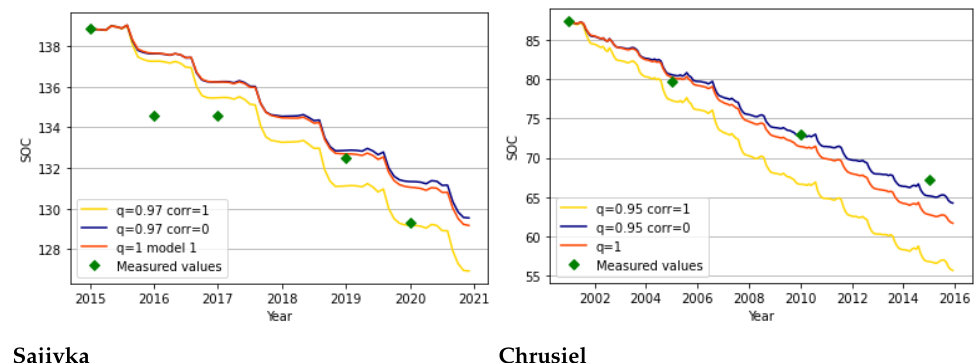
Figure 5. The values of SOC obtained for the integer-order and the fractional-order models (“corr = 0” means ζ ( t , q ) = 1, “corr = 1” means ζ ( t , q ) = t q − 1 ): left for the point “Sajivka”, right for the point “Chrusciel”.